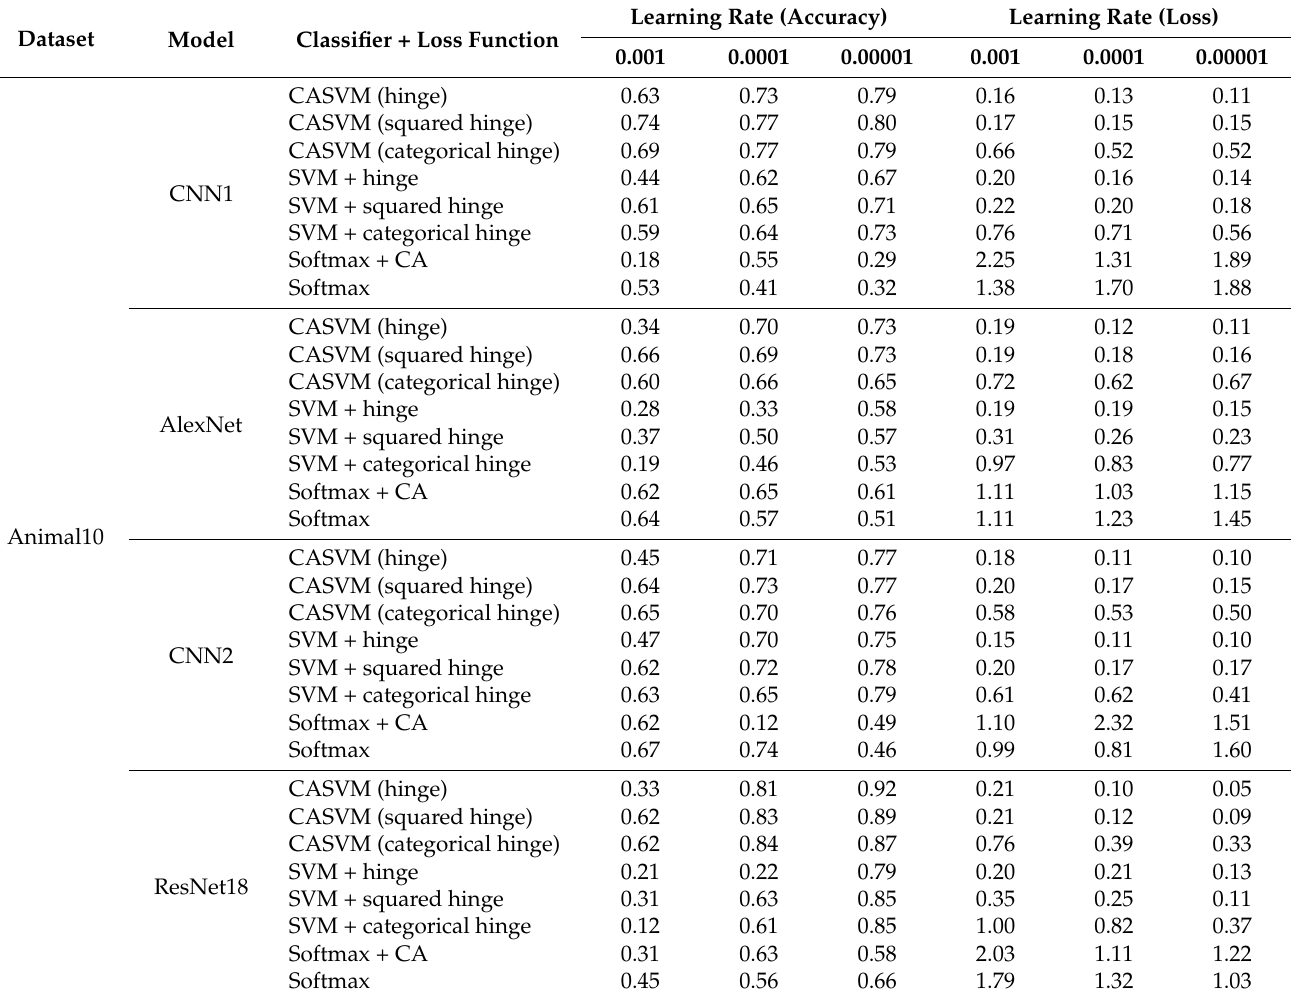
Table 5. Image classification accuracy and loss values for large